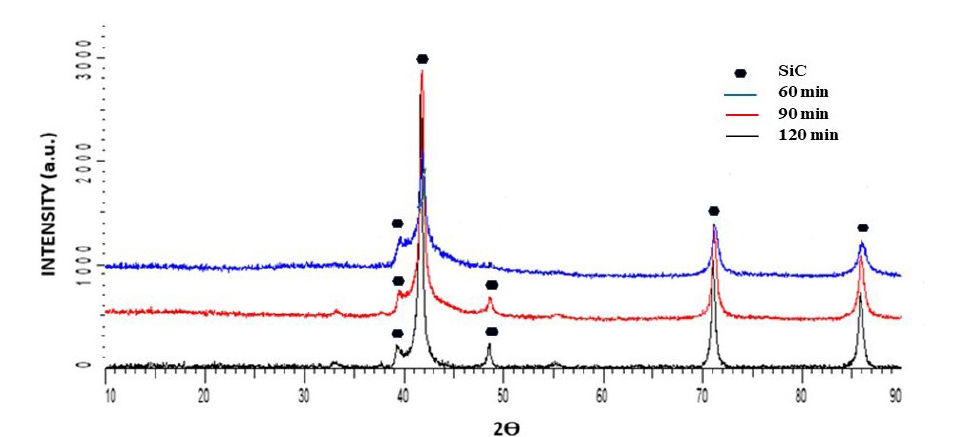
Figure 2: Composite XRD plot for leached pyrolysis products obtained at 1500 °C and different reaction times